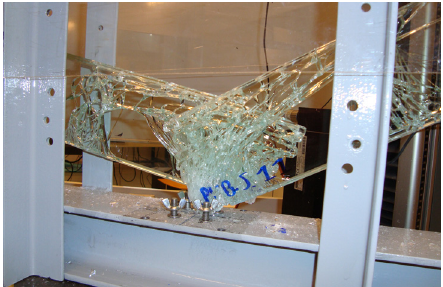
Figure 3: Collapse occurs immediately at initial failure in double layer PVB laminated heat strengthened glass beams tested in 4-point bending after no or partial predamage (this picture: no predamage), because of tearing of the PVB foil.